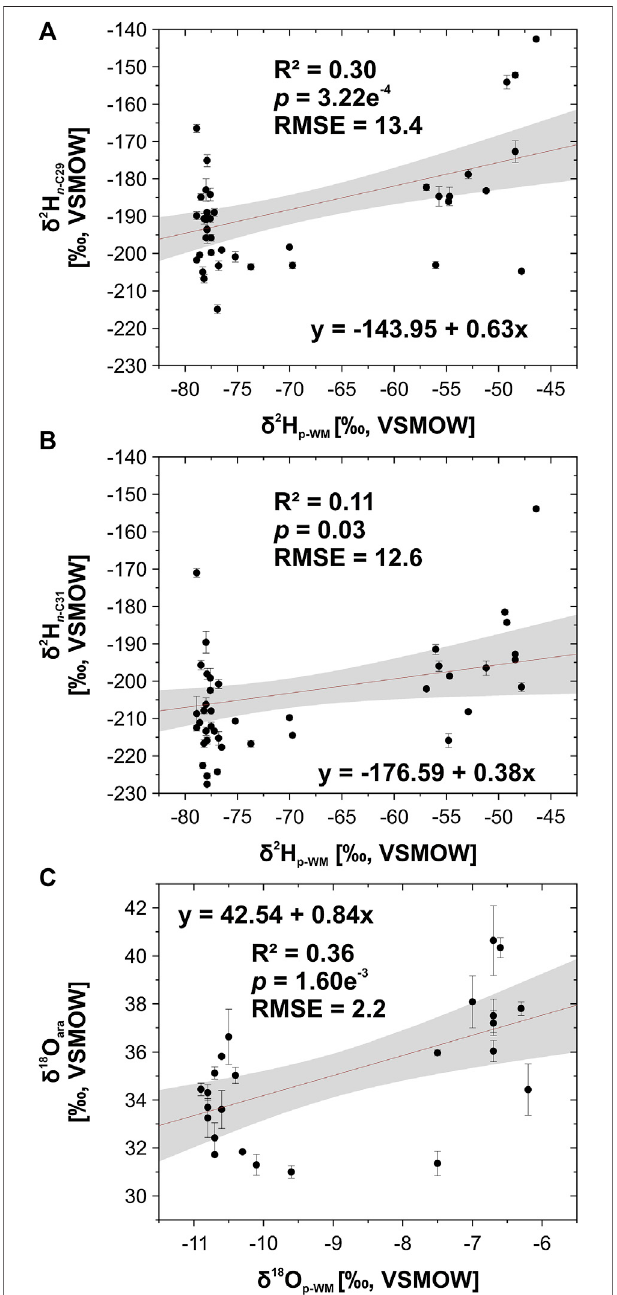
FIGURE 3 | δ 2 H signatures of the leaf wax-derived n -alkanes (A) n -C 29 and (B) n -C 31 , as well as (C) δ 18 O ara signatures from the topsoil transect through Mongolia plotted against the amount-weighted δ 2 H and δ 18 O signature of precipitation ( δ 2 H p-WM / δ 18 O p-WM ). Red trend lines illustrate linear regressions, gray shaded areas the 95% con fi dence interval. Bold R 2 / p -values indicate the level of signi fi cance ( α (cid:1) 0.05).